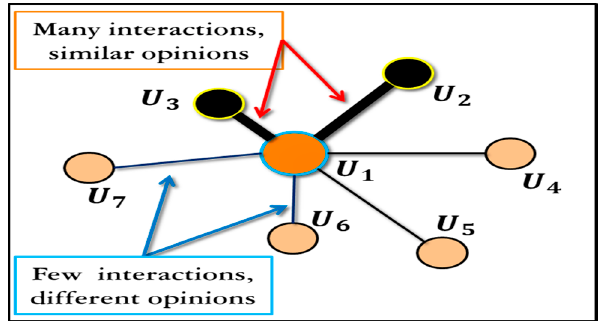
Figure 47. Social network mining to estimate the strengths of social relations among users (Ref. [156]).